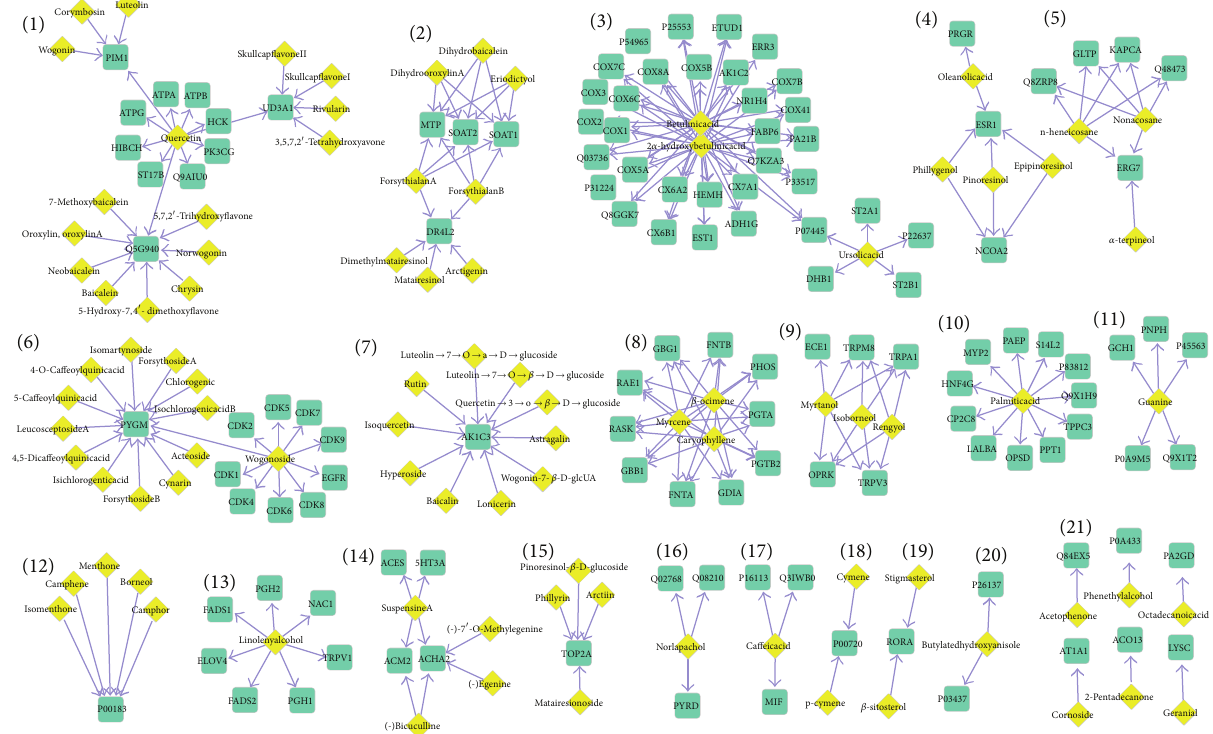
Figure 3: Drug-target Network of SHL. The components are yellow diamonds. The targets are shown as blue squares.